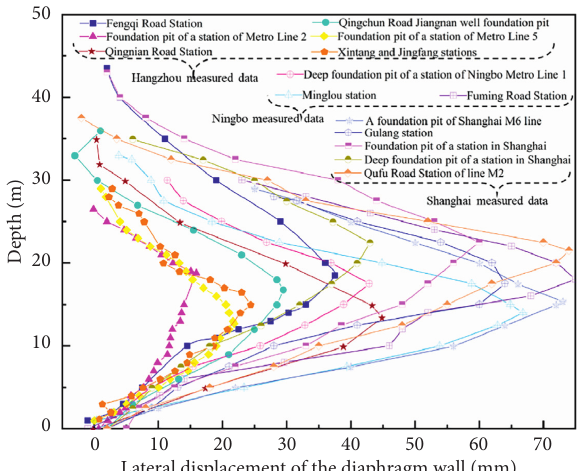
Figure 9: The measured curve of the lateral deformation of the wall.